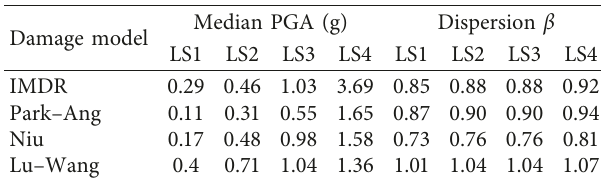
Figure 9: Comparative relationships for the SSI models based on (a) MIDR model and three double-parameter damage models: (b) Park–Ang model, (c) Niu model, and (d) Lu–Wang model. Table 6: Parameters of the fragility functions in terms of PGA for the analysed structure without considering SSI